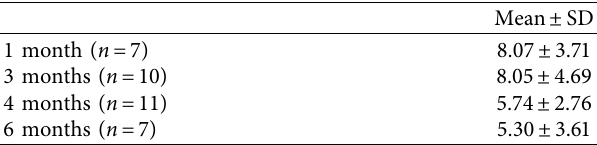
Table 1: Lamotrigine levels in plasma of BD patients treated at the dose of